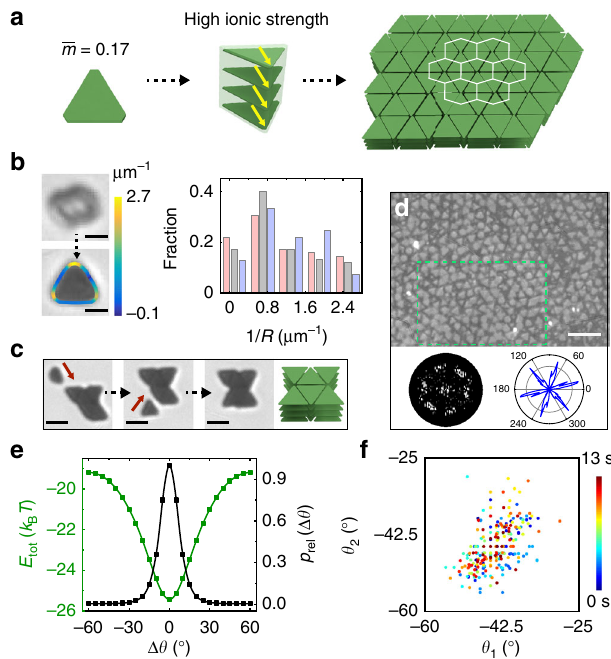
Fig. 4 Experimental observation of plates assembling into 3D honeycomb lattice domains. a Schematics showing the hierarchical self-assembly process. The plates here have the dimensions, L : 1.28 ± 0.27 µ m; L ′ : 0.19 ± 0.19 µ m; t plate : 22 ± 2 nm; (cid:1) m = 0.17. The yellow arrows denote the aligned plate orientations in the column. b Time-lapse optical microscopy images (left) showing the lying and standing orientations of the same rotating column. The bottom image is overlaid with contours color-coded according to local curvature. The color bar represents curvature values. The right plot shows the local curvature distributions of the standing column projection contours over time (pink: 0 s; gray: 1 s; purple: 1.5 s). Ionic strength: 3.2 mM. c Time-lapse optical microscopy images and schematic showing the assembly process of the columns into a “ hexamer ” . d An optical microscopy image of the assembled lattice with multiple ordered honeycomb domains. The image was processed following details in Supplementary Fig. 5. The bottom left image is an FFT of one honeycomb lattice domain in the green box. The bottom right plot is an orientation distribution map of the plates in the same lattice domain. e Pairwise interaction (green curve) and relative probability distribution normalized to Δ θ = 0° (black curve) of the two stacked plates as a function of plate relative orientation Δ θ . f A scatter plot showing the orientations of two plates in a nearest neighbor pair in the honeycomb domain over time. Each data point color corresponds to a different time. The measurement errors are ±2°. The color bar represents time. Ionic strengths in c – f : 3.5 mM. Scale bars: 1 µ m in b ; 2 µ m in c ; 5 µ m in